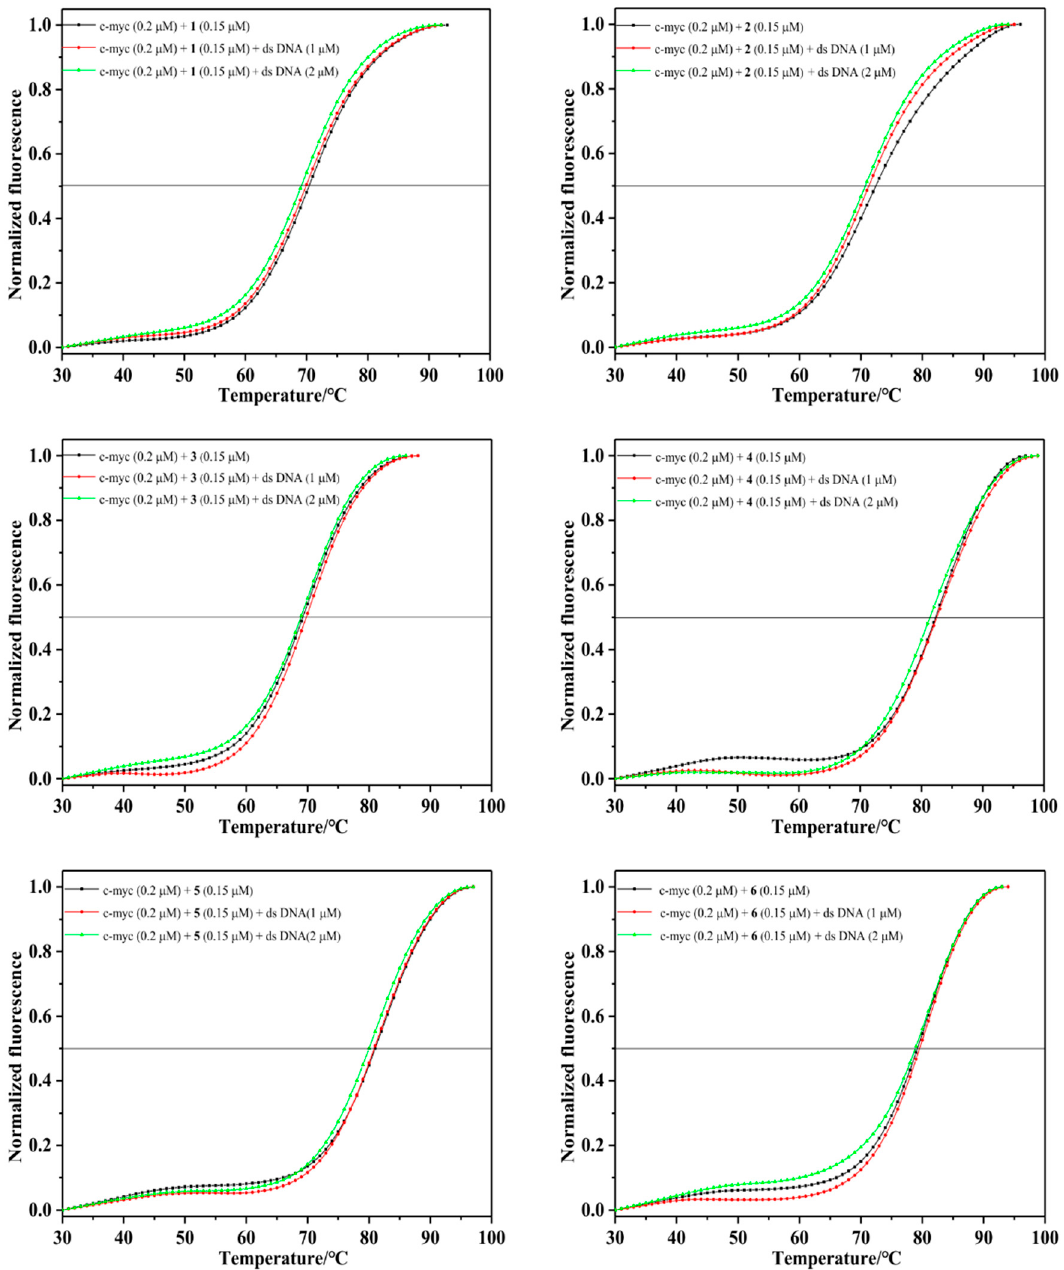
Figure 6. Competitive FRET-melting curves of c-myc (0.20 μ M) with 0.15 μ M of Ru(II) complexes ( 1 – 6 ) and a duplex competitor ds26 (1–2 μ M) in a buffer containing 100 mM